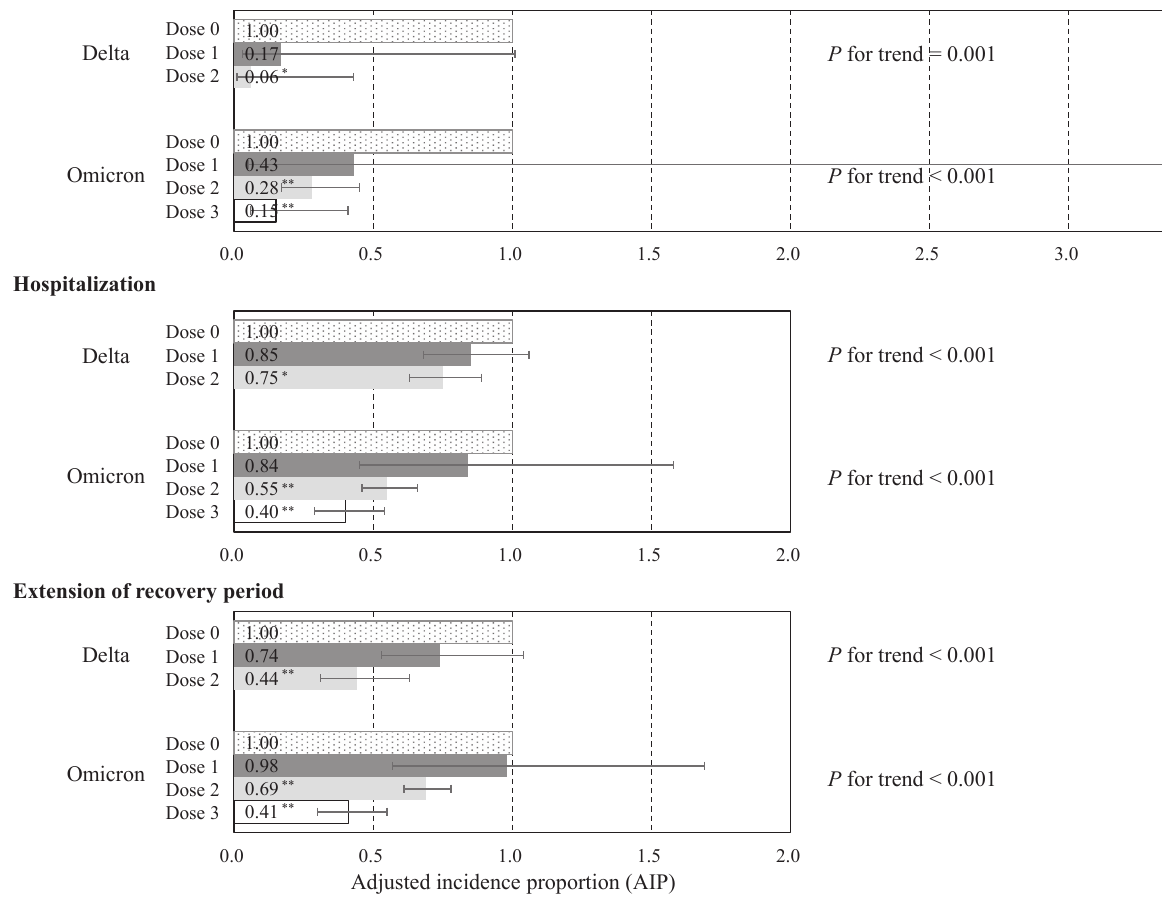
Fig. 2 Association of vaccination status with COVID-19-related health outcomes by SARS-CoV-2 variant type. Error bars display 95% con fi dence intervals. AIP was adjusted for gender, age, population size, the number of risk factors for aggravation, and the number of symptoms at diagnosis. Vaccination status was based on at least 14 days prior to infection. * < 0.050, ** <